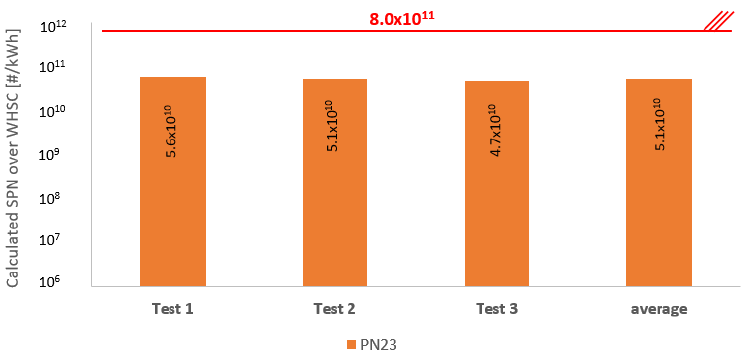
Figure 11. Calculated solid particle number results of each individual test, with DPF compared to Euro VI requirement.